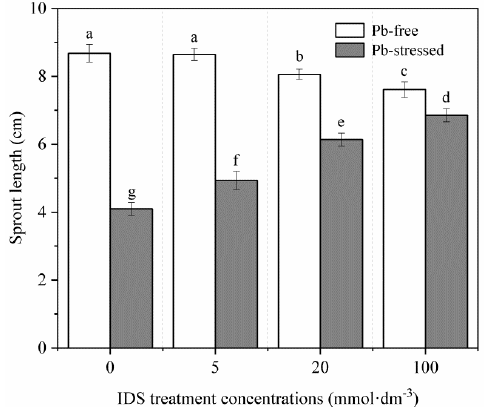
Figure 3. Effects of IDS on the sprout length of maize seedlings under Pb-stressed and Pb-free conditions. Maize seeds treated with Pb (20 mmol · dm − 3 PbCl 2 ) and distilled water were further treated with different concentrations (0, 5, 20, and 100 mmol · dm − 3 ) of IDS solutions. The sprout lengths of 5-day-old maize seedlings were measured. Error bars represent the standard deviation of the mean ( n = 5). Means associated with different letters are significantly different between